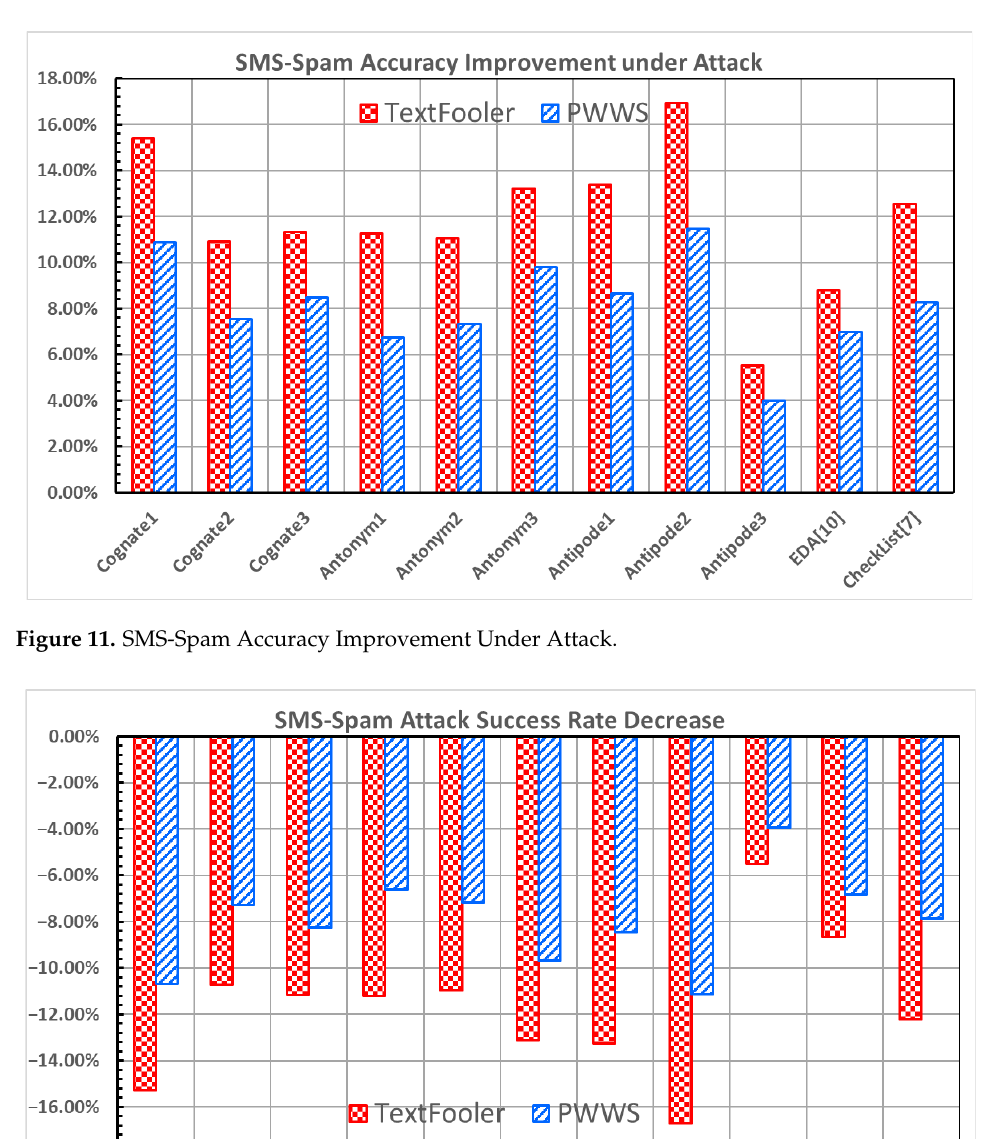
Table 2. Target Models on AG-News. Models